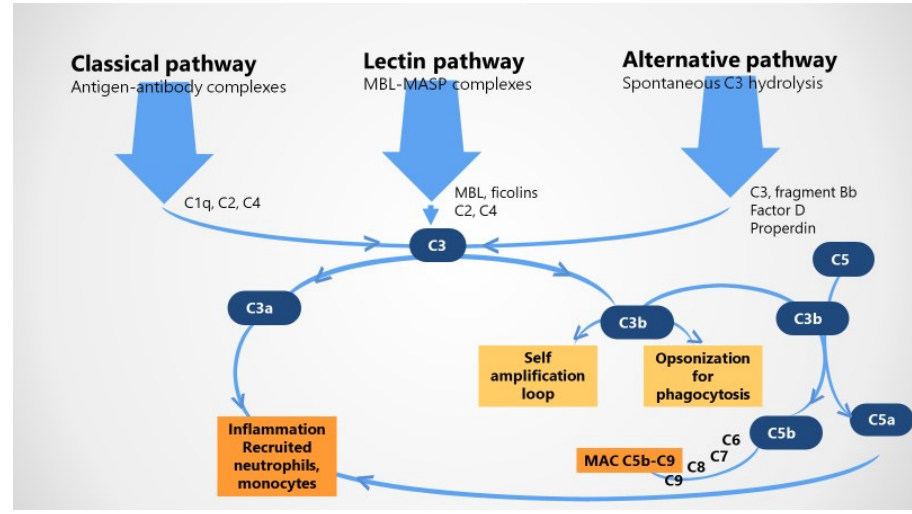
Figure 1. Extracellular complement activation pathways.